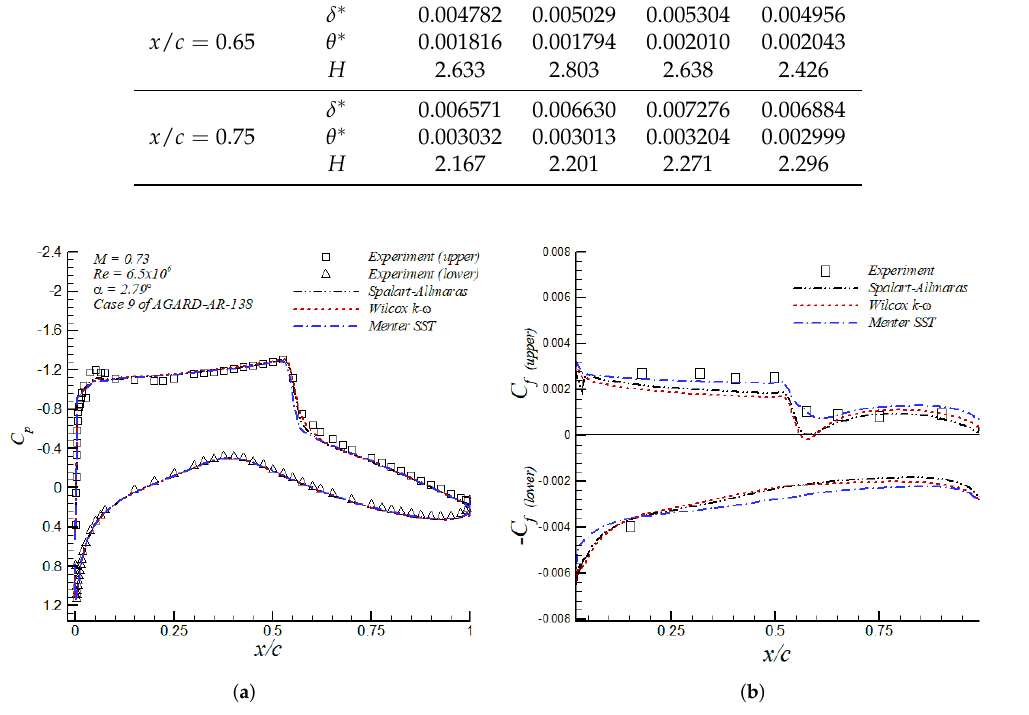
Figure 4. Pressure ( a ); and skin friction ( b ) coefficient in the RAE2822 airfoil.